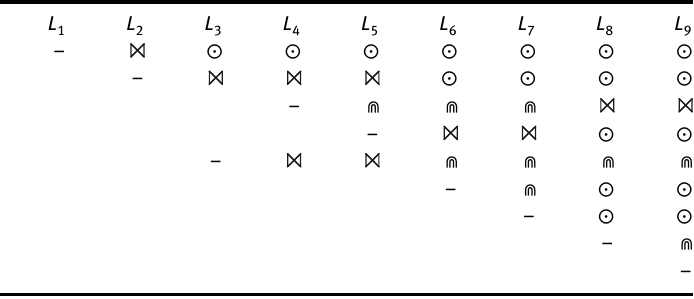
Table 2: The relation matrix of the secondary structure of RNA–RNA interaction shown in Figure